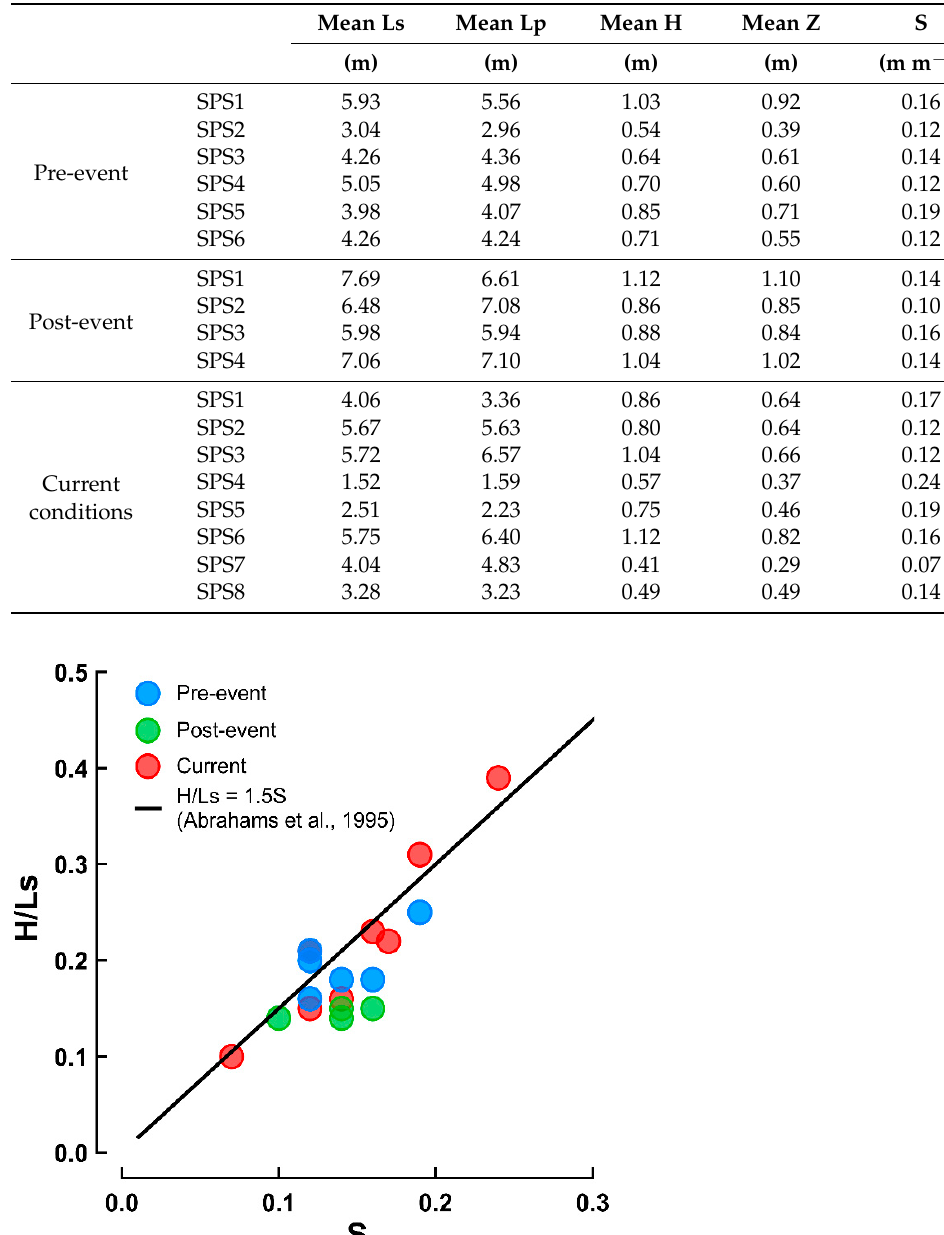
Table 3. Mean values of step–step spacing (Ls), pool–pool spacing (Lp), step–pool height (H), step–step drop (Z), and slope of each sequence (SPS) identified pre-event, post-event, and in the current conditions.